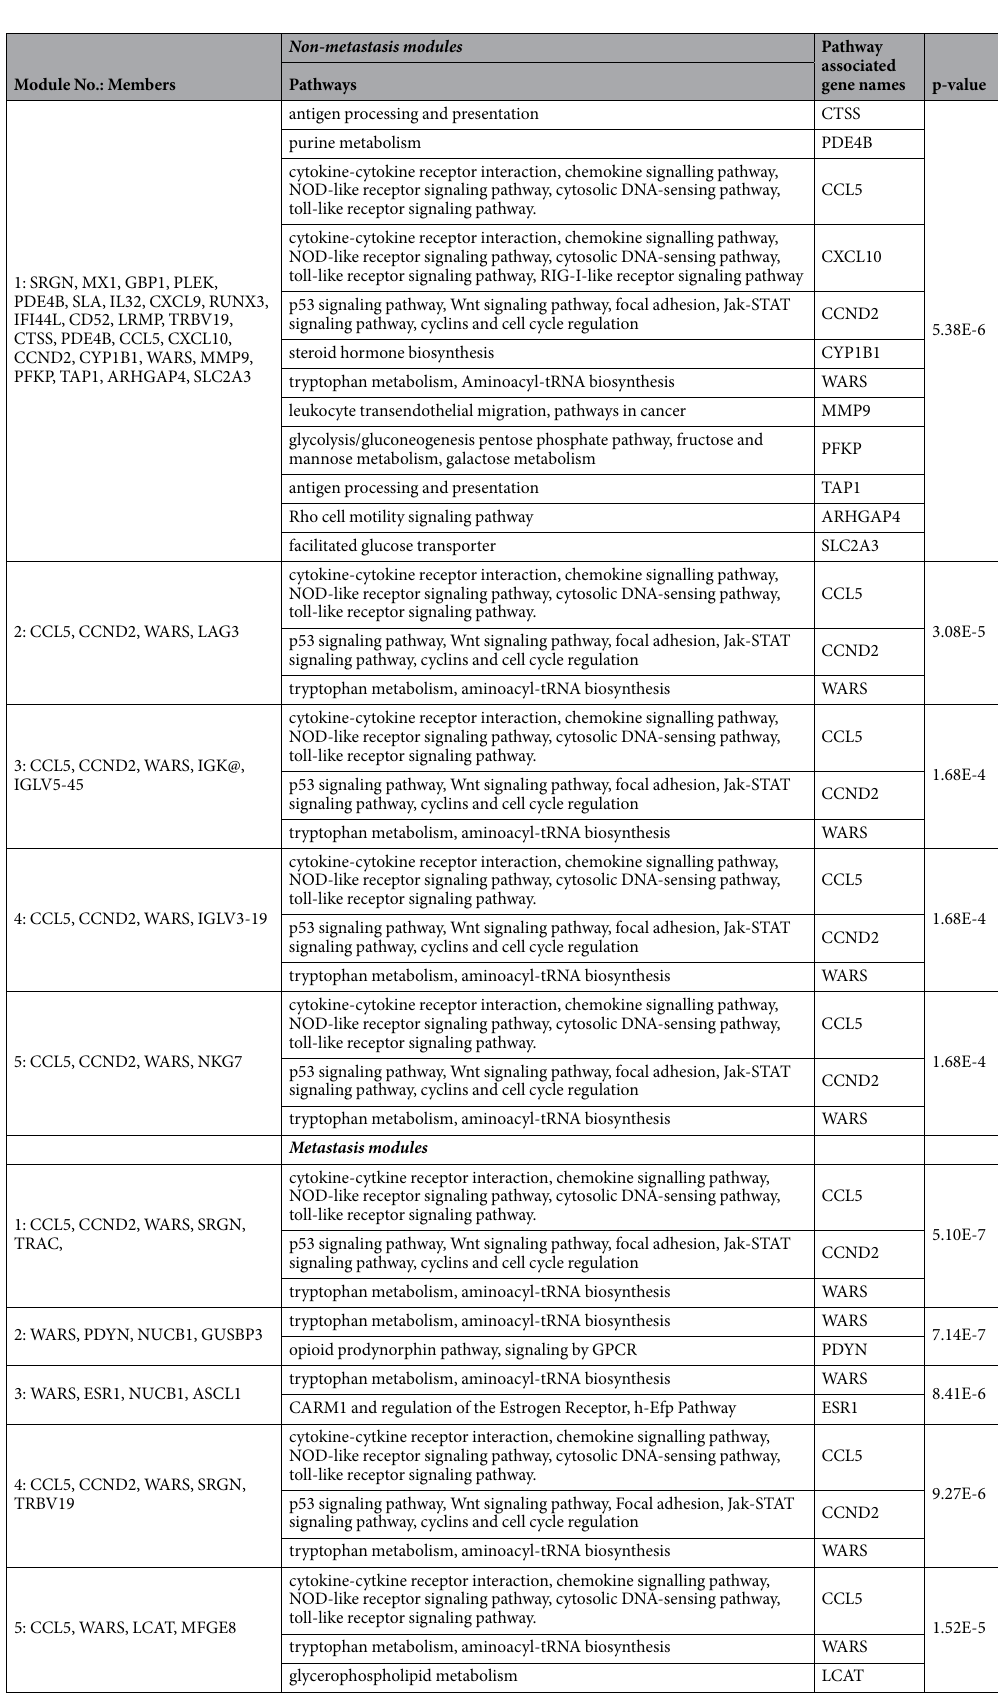
Table 2. Non-Metastasis and Metastasis modules along with pathway information and